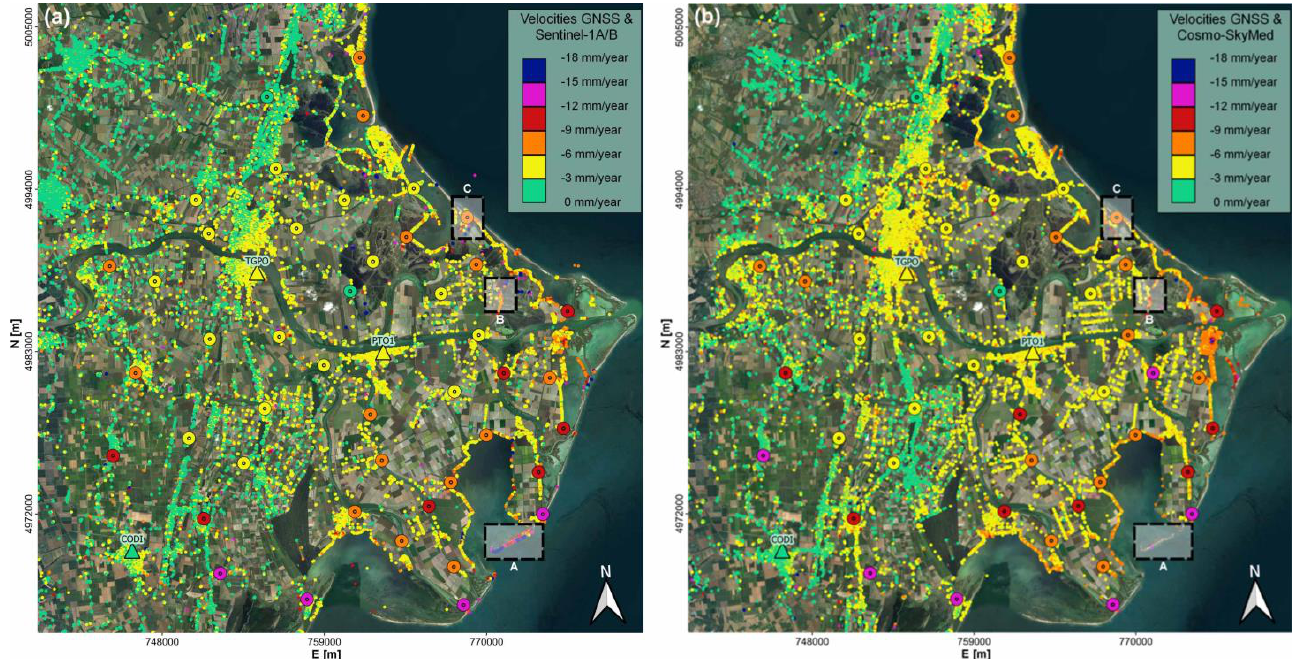
Figure 8. Kinematic pattern of the LOS velocities in the study area: ( a ) GNSS and Sentinel-1 points; ( b ) GNSS and CSK points. The A, B, and C areas are shown in detail in Figure 9.